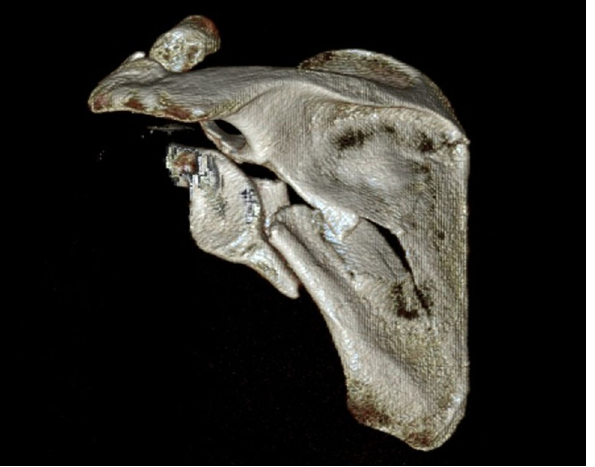
Figure 1: Left scapular fracture – 3D CT reconstruction.